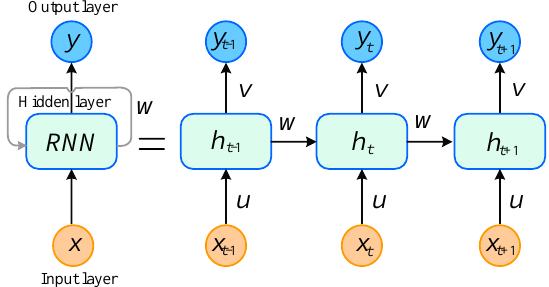
Figure 2. The structure of an RNN.